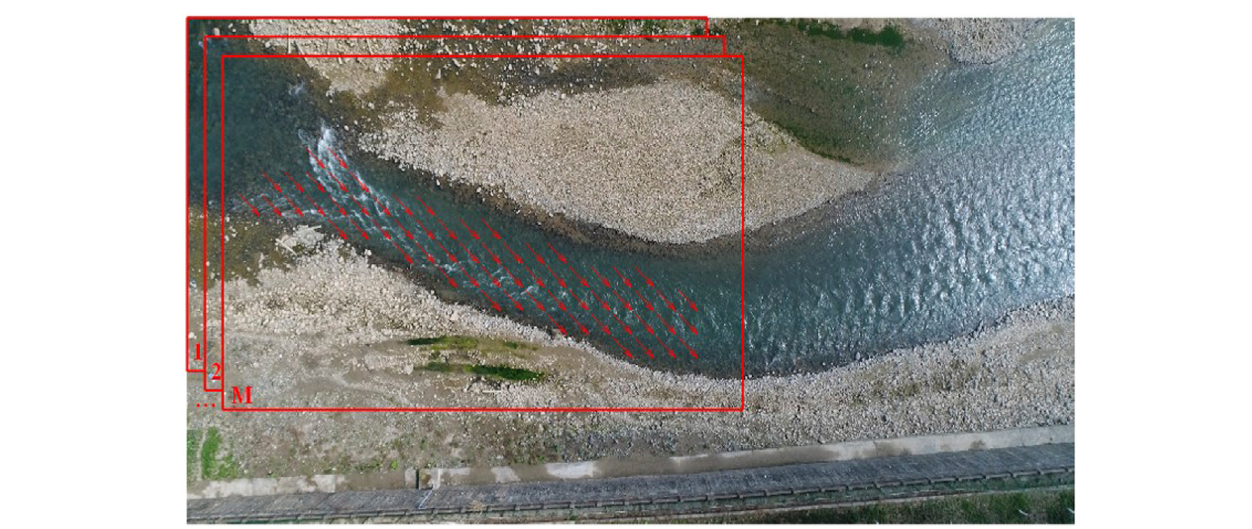
FIGURE 6 | Simulated images of river sequence. The Area1 represents a 1760 × 2,425 part on a 2,160 × 3,840 image extracted from the UAV video of the Xiasi River.TheArea M isobtainedfromArea1moving m pixelshorizontallyand n pixelsverticallyontheframeofimage.Theredarrowsarevelocitiesofthesimulatedimages1 to M when m is 1 pixel, n is 1 pixel.